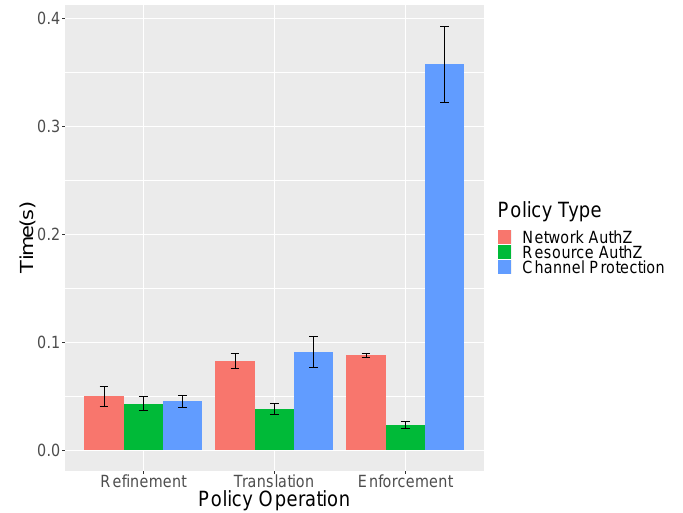
Figure 7. Mean time of policy operation per policy